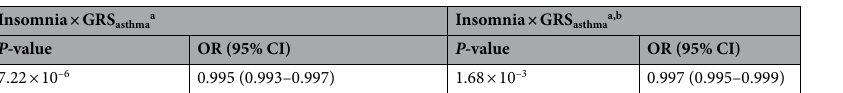
Table 3. Intercation effect of GRS asthma with insomnia on asthma. a Model was adjusted for covariates: age, age 2 , sex, batch size, and 10 principal components. b Interaction terms were adjusted for covariates: age, age 2 , and